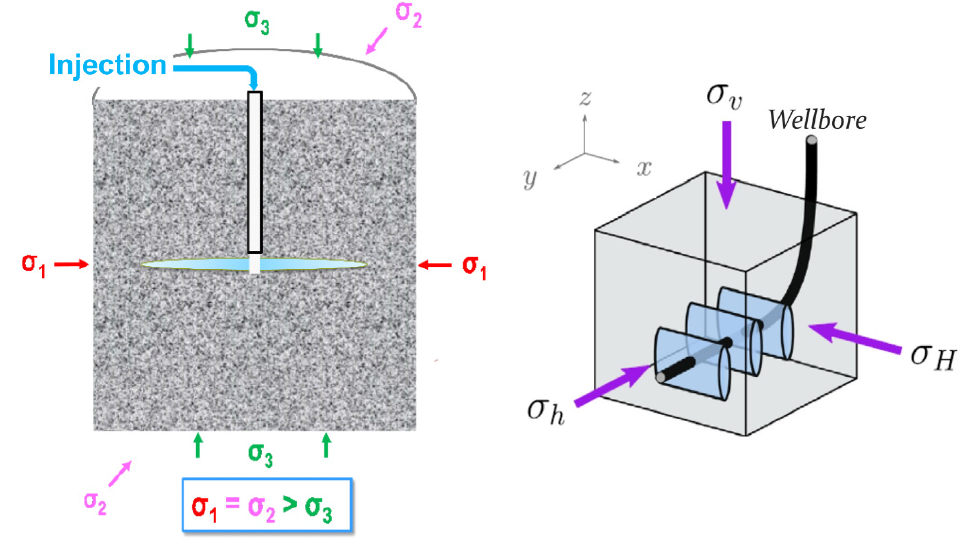
Figure 5. Sketch of stresses applied to the cylindrical sample with a vertical well for fluid injection ( left ) and a scheme of stress state orientation along the horizontal well in a rock mass ( right ) [41].